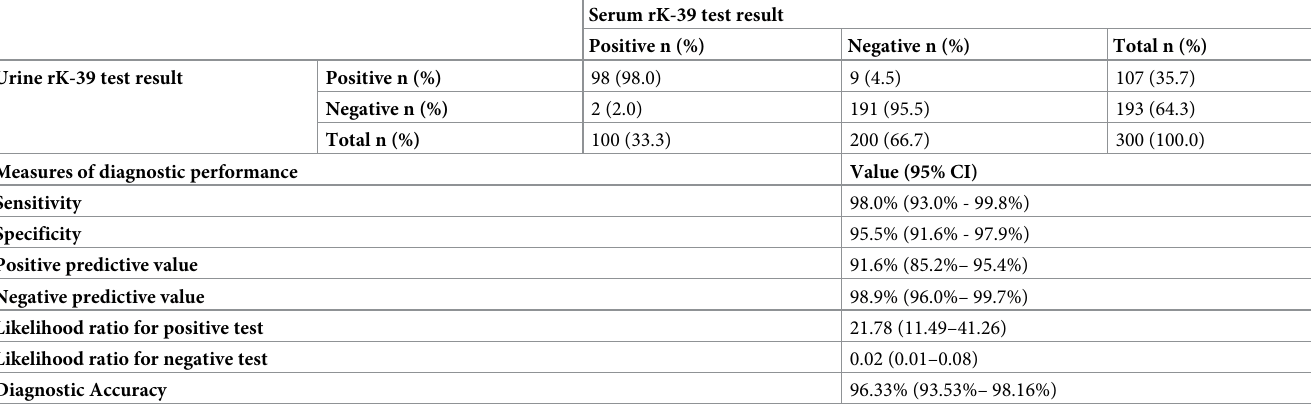
Table 2. Urine rK-39 test results compared to rK-39 test results by using serum sample, Northwest